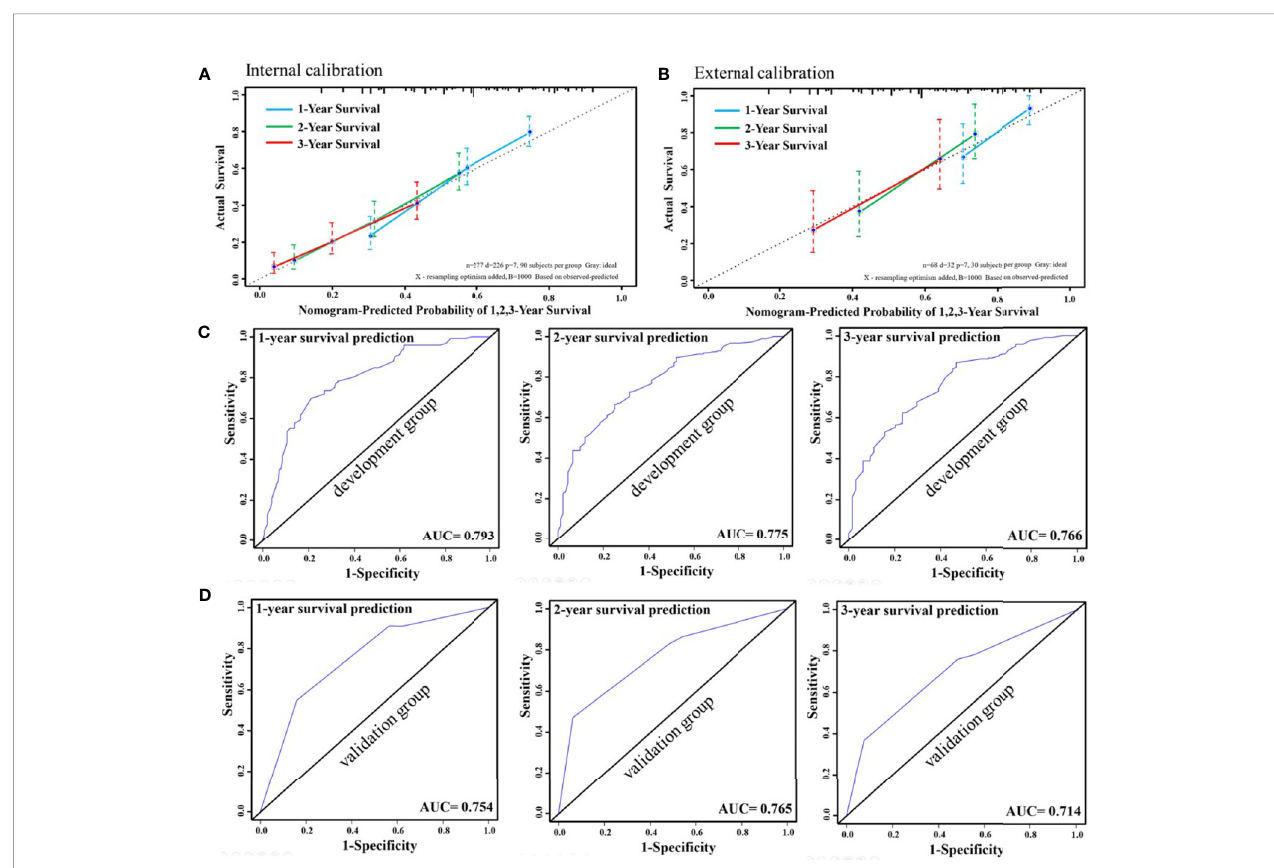
FIGURE 3 | Internal calibration curve to validate nomogram model for 1-, 2-, and 3-year survival and its C-index was 0.701 (95% Cl, 0.666 – 0.736) (A) . External calibration curve to validate nomogram model for 1-, 2-, and 3-year survival and its C-index was 0.716 (95% Cl, 0.622 – 0.810) (B) . ROC curve of 1-, 2-, and 3-year survival prediction in the development group (C) . ROC curve of 1-, 2-, and 3-year survival prediction in the validation group (D) .